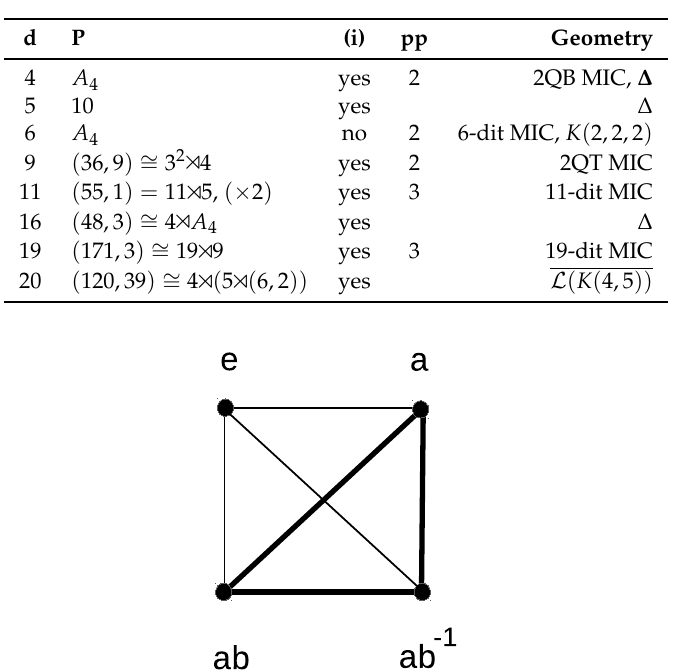
Figure 5. The contextual geometry associated to the 2QB-MIC and permutation group P = A 4 in Table 1. The line/triangle a, ab, ab is not made of mutually commuting cosets, thus geometric contextuality occurs.